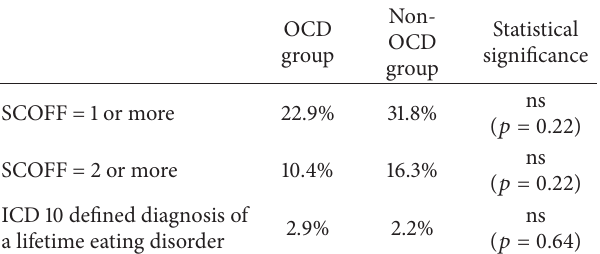
Table 3: Comparative prevalence of eating disorders in both groups (entire sample, 179).